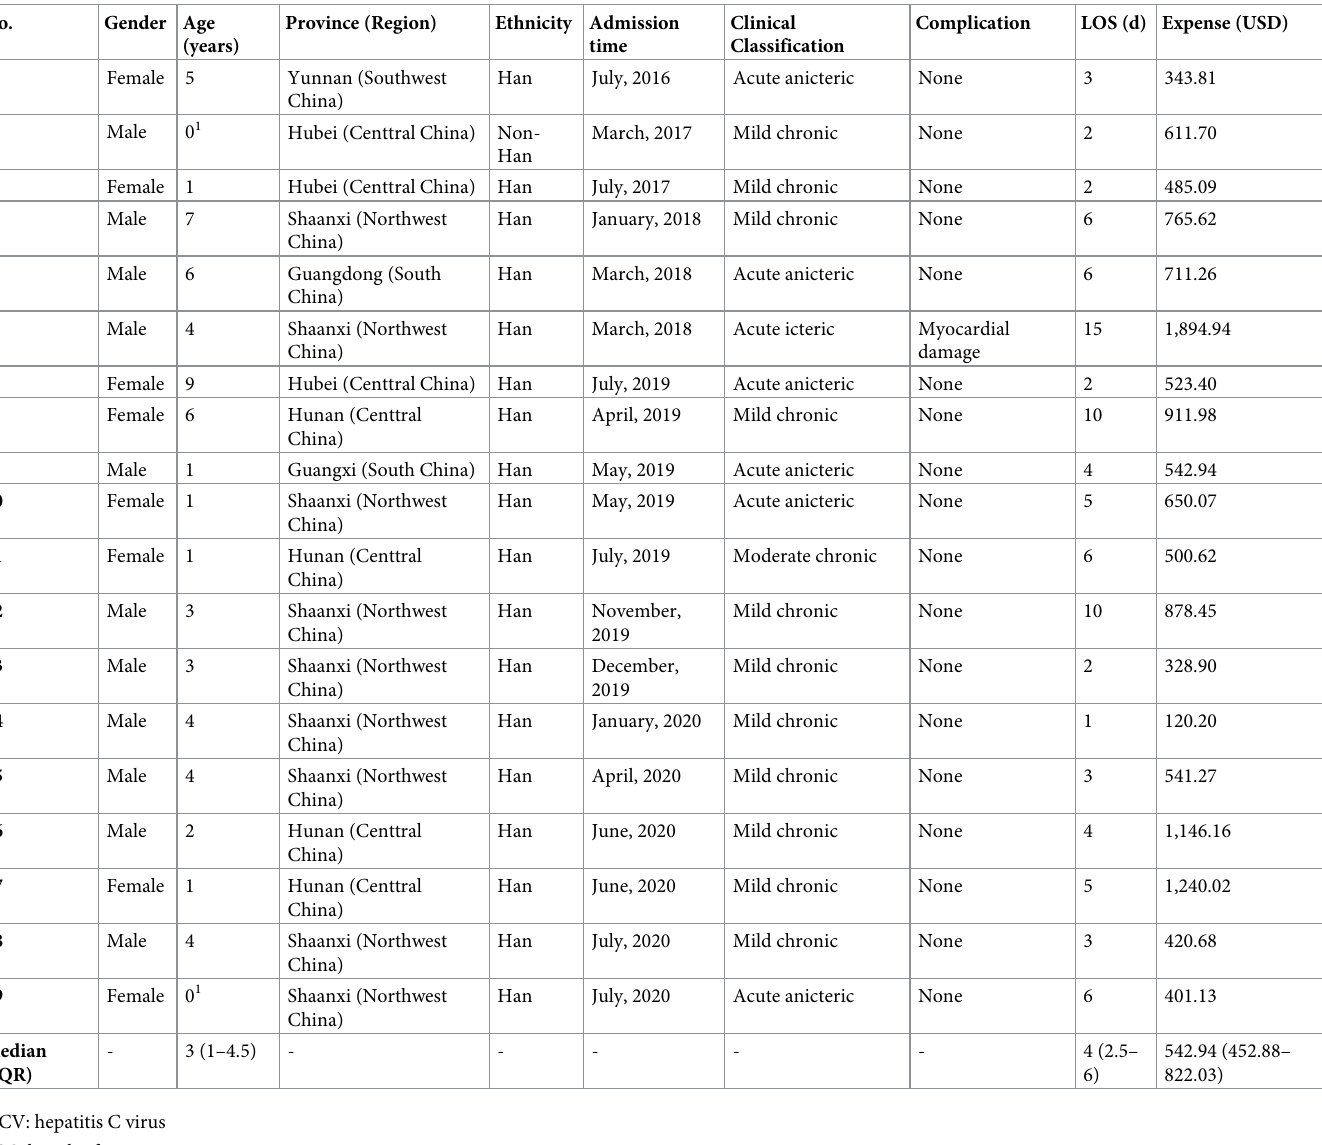
Table 8. The general sociodemographic characteristics and disease burden of HCV infection during pediatric hospitalizations from December 2015 to December 2020.